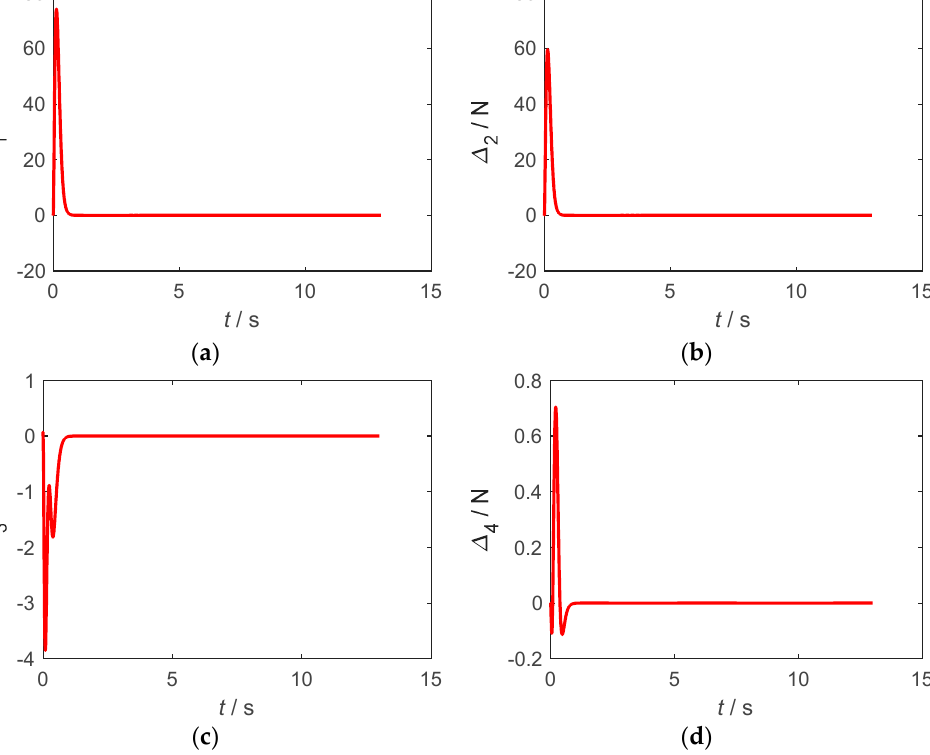
Figure 10. The tracking error of unknown system dynamic estimator. ( a ) The carrier O 0 . ( b ) The joint O 1 . ( c ) The joint O 2 . ( d ) The joint O 3